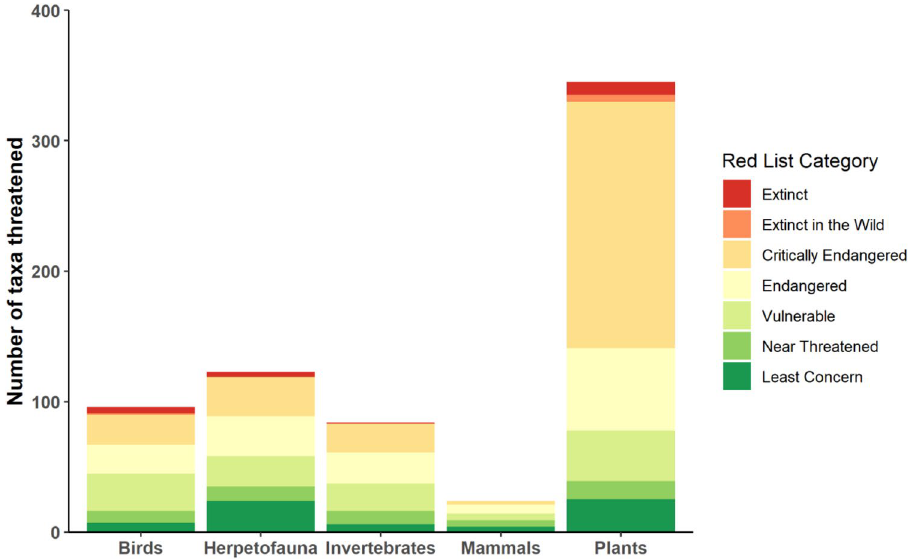
Figure 2. Quantity of taxa categorized by their IUCN Red List Category (fill colors) including all majorly, minorly, or potentially threatened taxa by wild pigs on the IUCN Red List. Taxa shown include all threatened taxa within the native or non-native ranges of wild pigs.